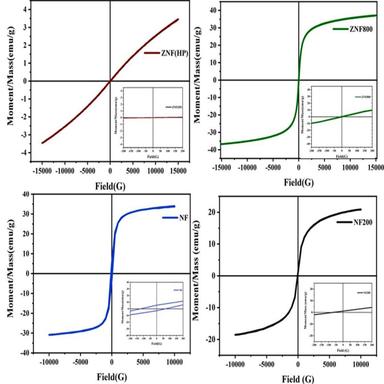
Room temperature magnetization of ZNF(HP), ZNF800, NF and ZF200.